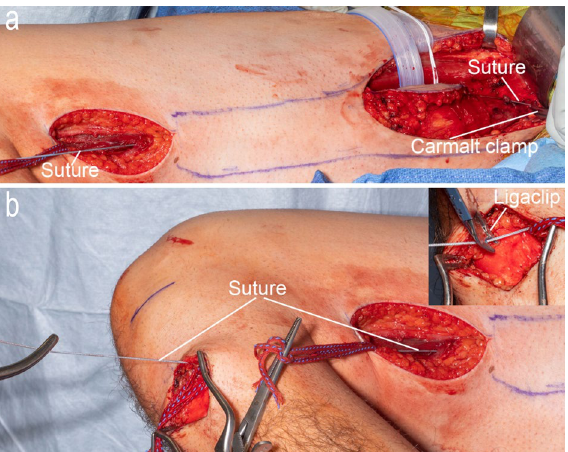
Figure 9. MTU length measurement. ( a ) One end of the suture is held at the gracilis origin and threaded from the proximal thigh incision to the distal thigh incision. ( b ) The suture is passed from the distal thigh incision out through the incision at the pes anserine . The inset image shows a titanium Ligaclip being used to mark the length of the MTU at the pes anserine .